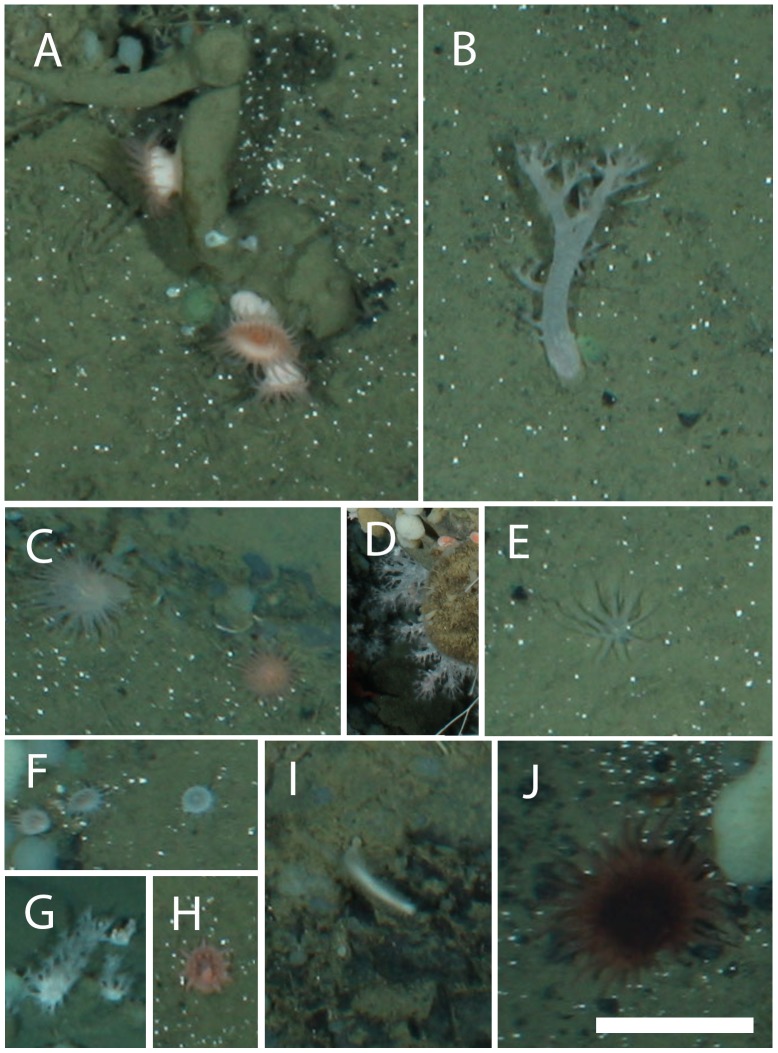
Cnidarians observed at the deep reef.A, Hormathiidae; B, Gersemia; C, Bathyphellia margaritacea; D, broccoli soft coral; E, large white cerianthid; F, small white actinarian; G, fringe anemone; H, short-tentacled pink anemone; I, sea pen; J, large red anemone. Scale bar  = 5 cm.